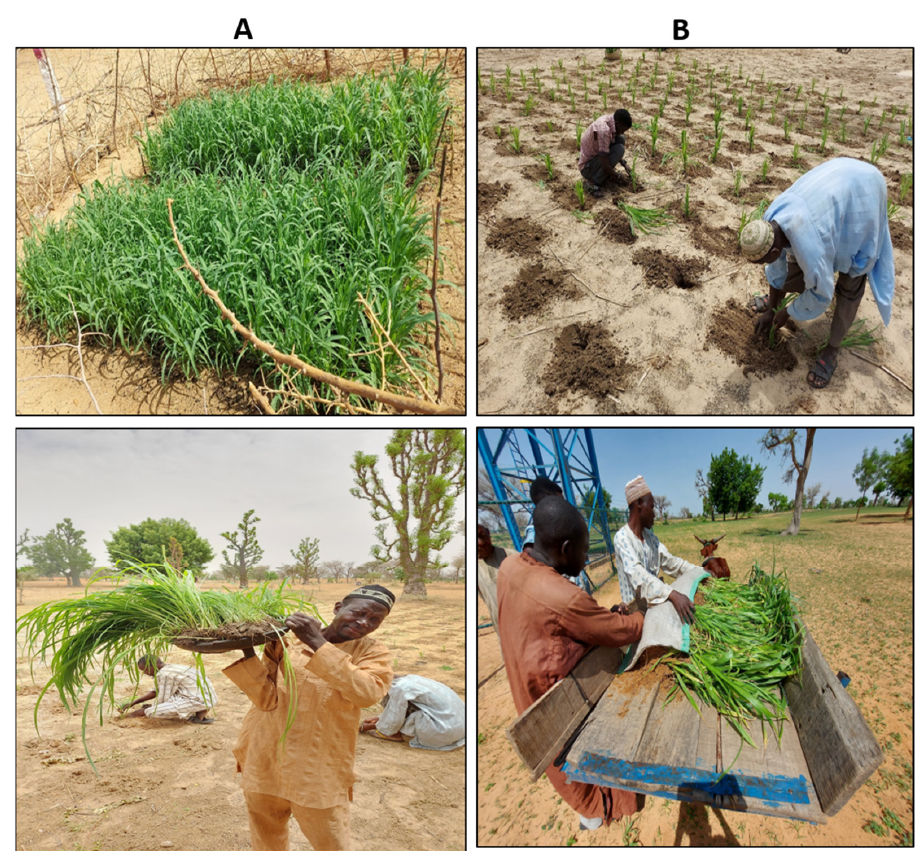
Figure 2. Nursery ( A ) and transplanting operations ( B ) at the village of Dan Kirey.